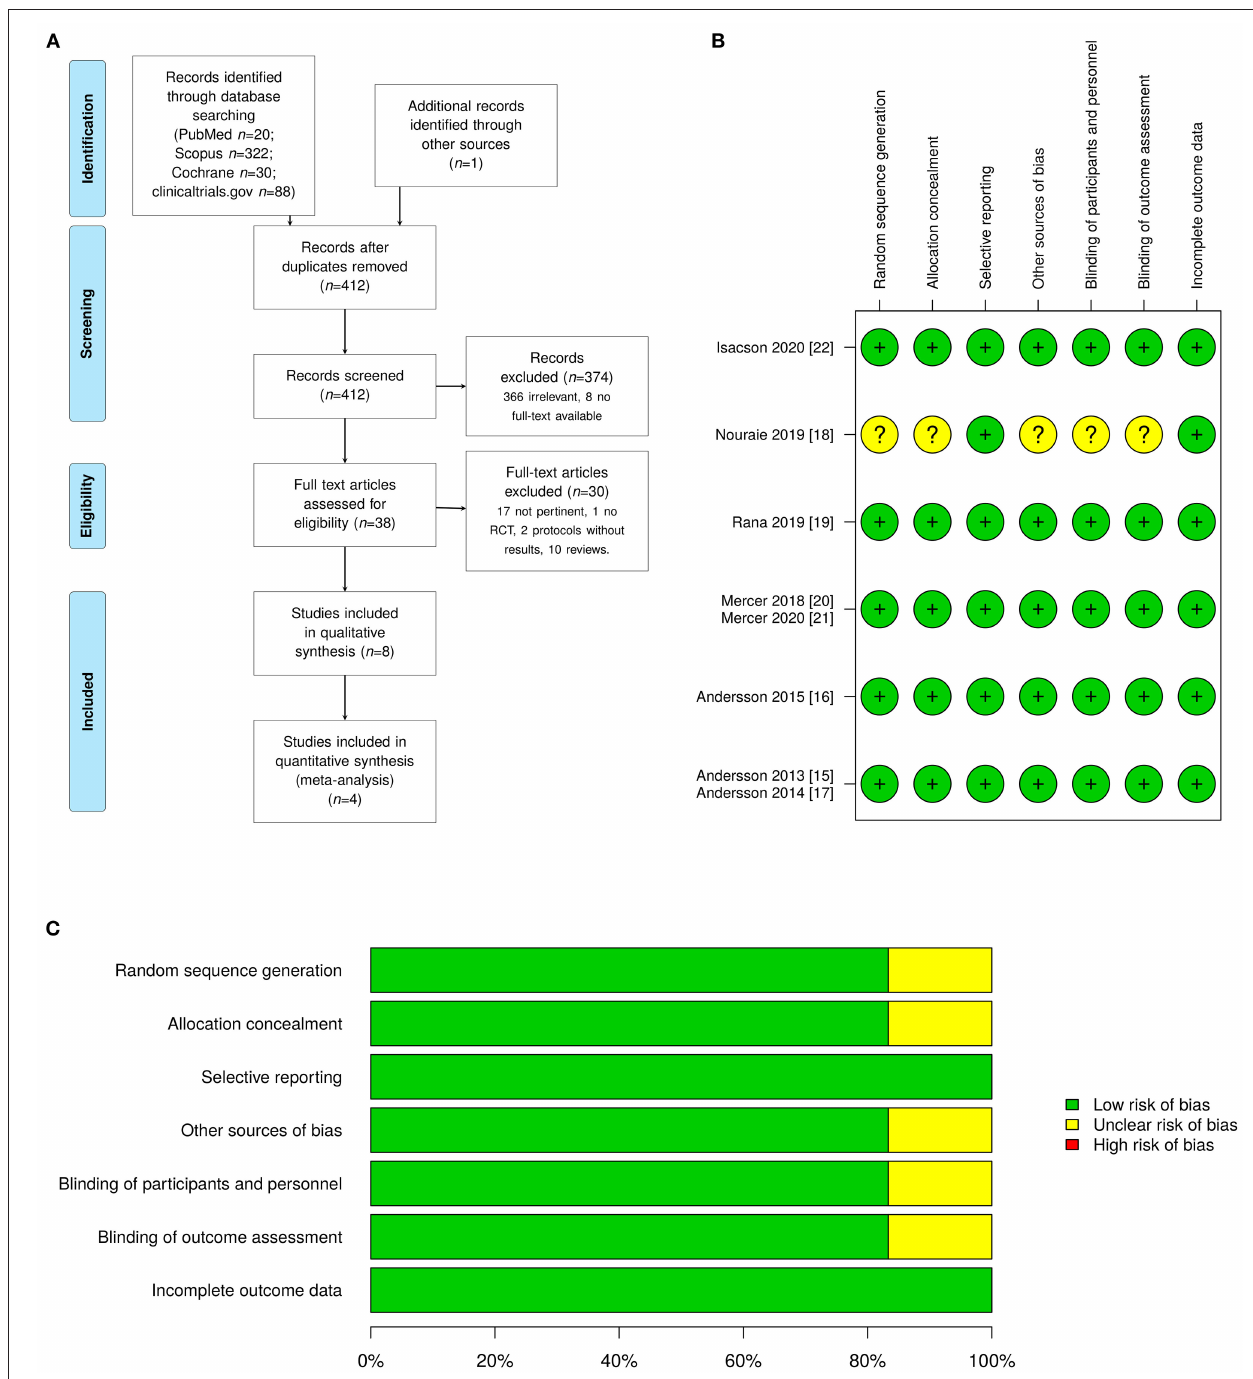
FIGURE 1 | (A) The PRISMA flow diagram showing the literature search and selection. (B) Study quality summary, which includes our judgements about each risk-of-bias item for each included study [colors legend: green ( + ) as low risk of bias (high quality), yellow (?) as unclear, and red (–) as high risk of bias (low quality)]. (C) Methodological quality score summary shown as percentage of all included 6 trials (denominator) published in 8 articles.